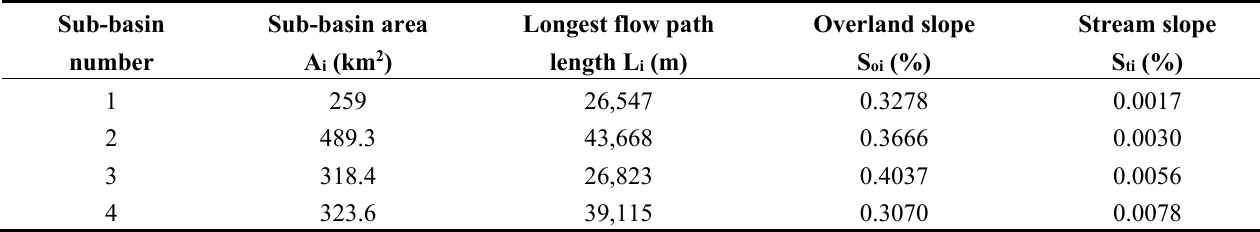
Table 2. Information about